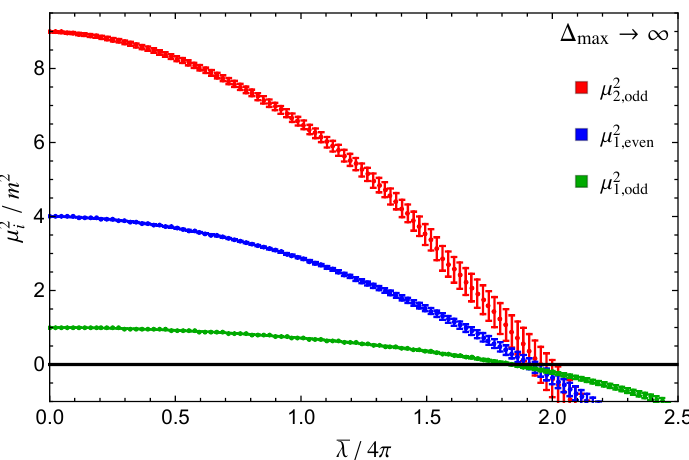
Figure 4 . The two lowest mass eigenvalues in the odd sector and the lowest eigenvalue in the even sector as a function of (cid:22) (cid:21) in the extrapolated limit (cid:1) max ! 1 .